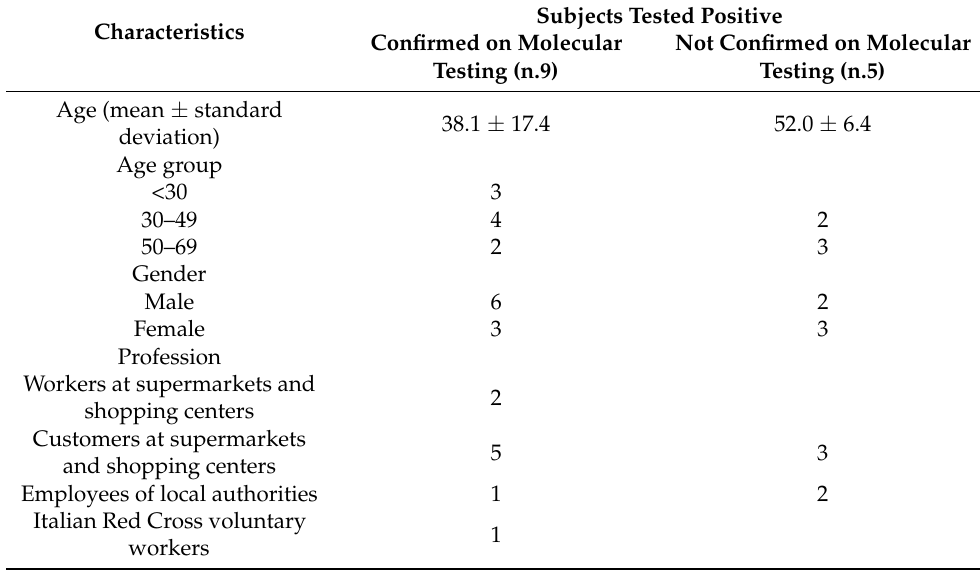
Table 2. Characteristics of the subjects tested positive for COVID-19 on screening